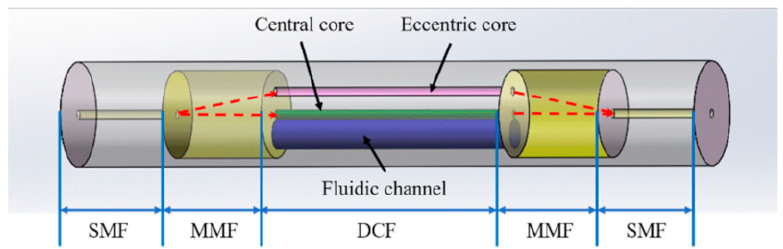
Figure 3. Schematic illustration of the SMF–MMF–DCF–MMF–SMF structure of the temperature sensor. SMF—single-mode fiber, MMF—multi-mode